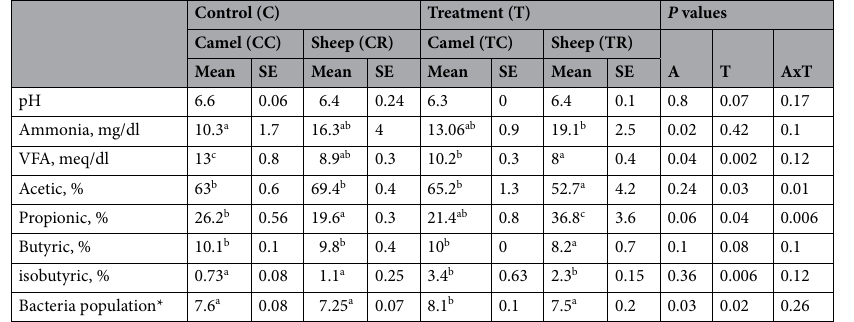
nificantly ( P < 0.05). For example, the molar proportions of propionic was increased in supplemented sheep (TR) and decreased in the supplemented camel (TC). The molar proportion of isobutyric was increased in camels and sheep by YA supplementation. Additionally, the bacterial population was affected by YA supplementation and animal species ( P < 0.05) as it was increased in supplemented camels (TC). Blood parameters. The effect of YA supplementation and animal species on serum biochemical param- eters and serum immunoglobulins IgA, IgG, and IgM are presented in Table 5. Animal species and YA sup- plementation affected the concentration of most of the serum biochemical parameters and serum immuno- globulins ( P < 0.05). Higher IgA was observed in camel group CC; and camel group TC showed higher glucose, triglycerides, IgG, and IgM. Moreover, sheep group TR showed higher total protein. Bacterial diversity and composition. The sequencing of the V4 region on the 16S rDNA gene in 12 rumen samples resulted in 393 690 high-quality sequence reads with an average of 32 807 sequences per sample. Table 6 presents the effect of animal species and YA supplementation on the alpha diversity metrics. The results showed that feeding treatment and animal species affected the microbial diversity indices significantly ( P < 0.05). Chao1 index was increased in camel group TC compared to CC and was declined in sheep group TR compared to CR. Shannon and InvSimpson indices were increased by YA supplementation. Principle Coordinate Analysis (PCoA) based on Bray Curtis dissimilarity metrics showed that bacterial communities of CC, CR, TC, and TR groups were separated distinctly by feeding treatment and animal species (Fig. 1).